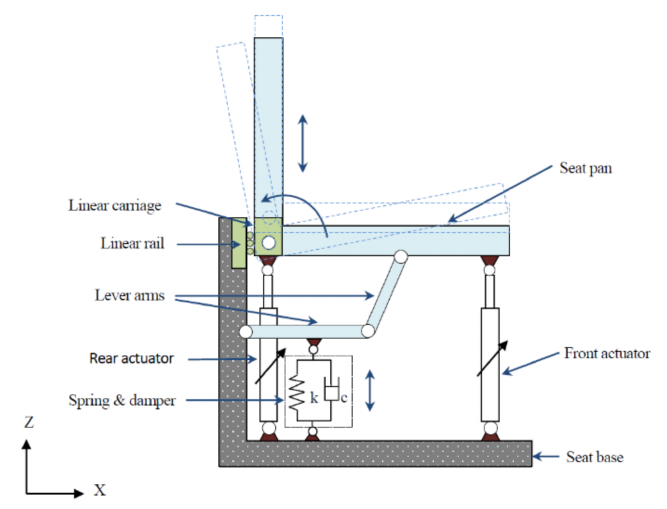
Figure 10. General experimental setup and HIL simulation of the proposed controllers. Thick Blue (active control force); Black (feedforward states); Red (Feedback states).